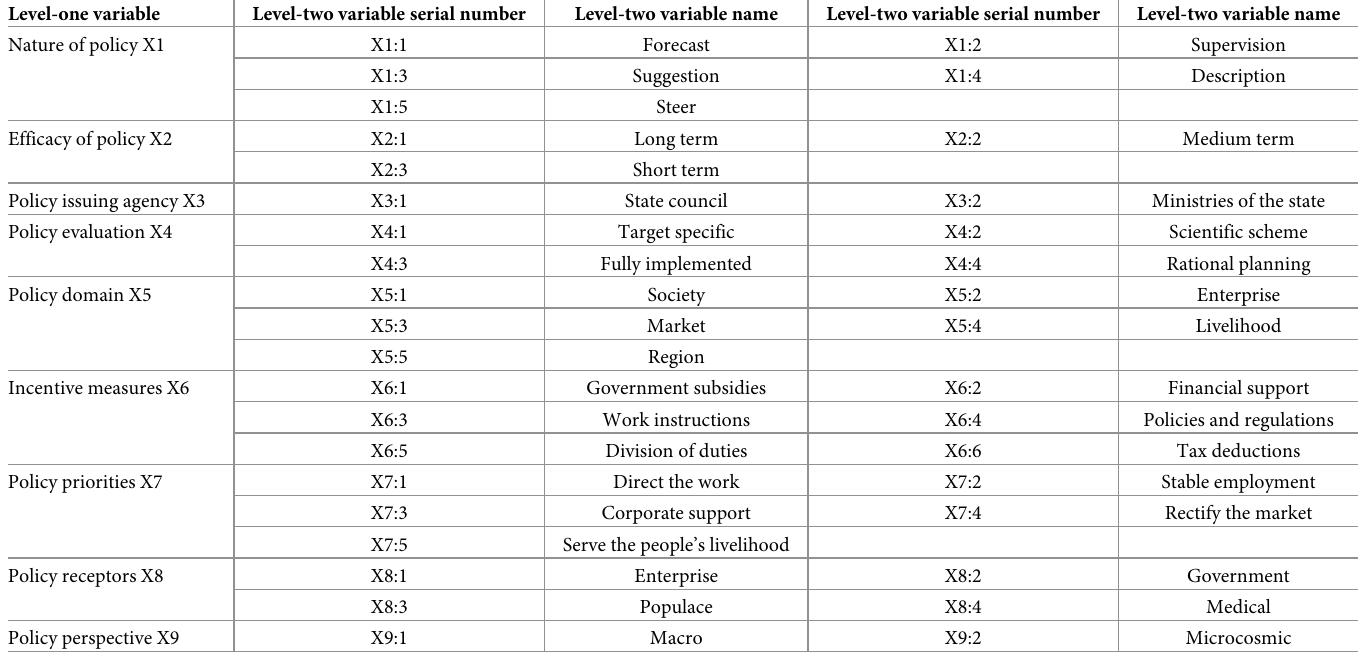
Table 2. Variable design of PMC evaluation index